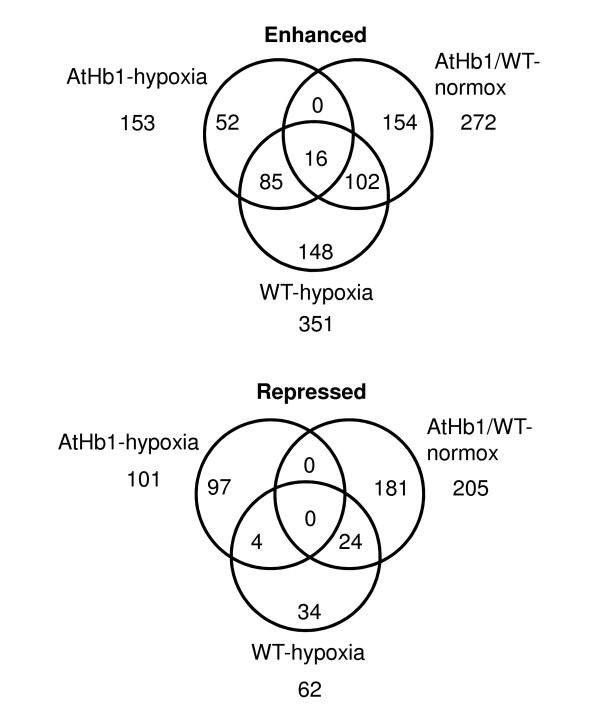
Venn diagrams showing overlap of differentially expressed genes due to AtHb1 overexpression and genes involved in the hypoxic response of WT and/or AtHb1 plants. Overlap of differentially expressed genes was identified using the Venn Super Selector of the web-based tool BAR (http://bbc.botany.utoronto.ca/).